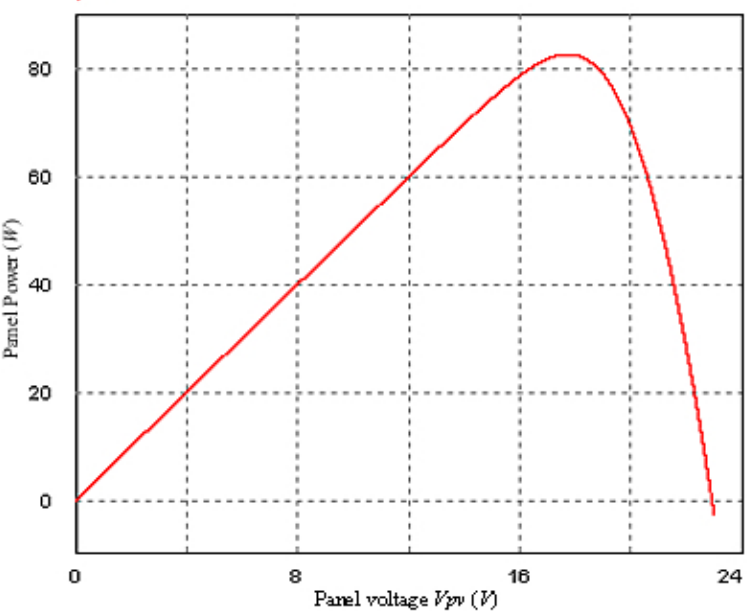
Figure 2. Voltage-Power characteristic in photovoltaic panel